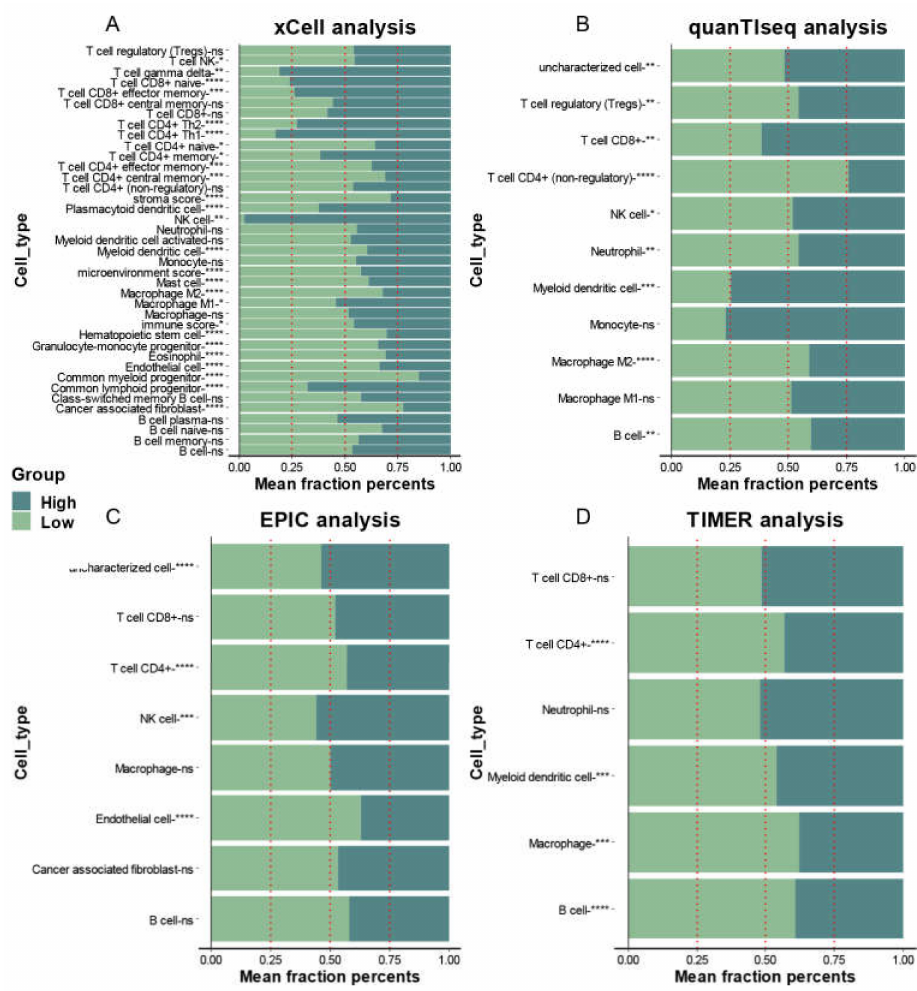
Figure 7. The association between infiltration level of immune cells and the mitophagy groups in LUAD. The xCell analysis ( A ), quanTIseq ( B ), EPIC ( C ) and TIMER ( D ) analyses of the two mitophagy groups. The x-axis is the mean cell fraction of a specific tumor immune contexture. The asterisks represented the statistical p value (* p < 0.05; ** p < 0.01; *** p < 0.001; **** p < 0.0001). Table 1. The potential drugs that targeted to high risk mitophagy